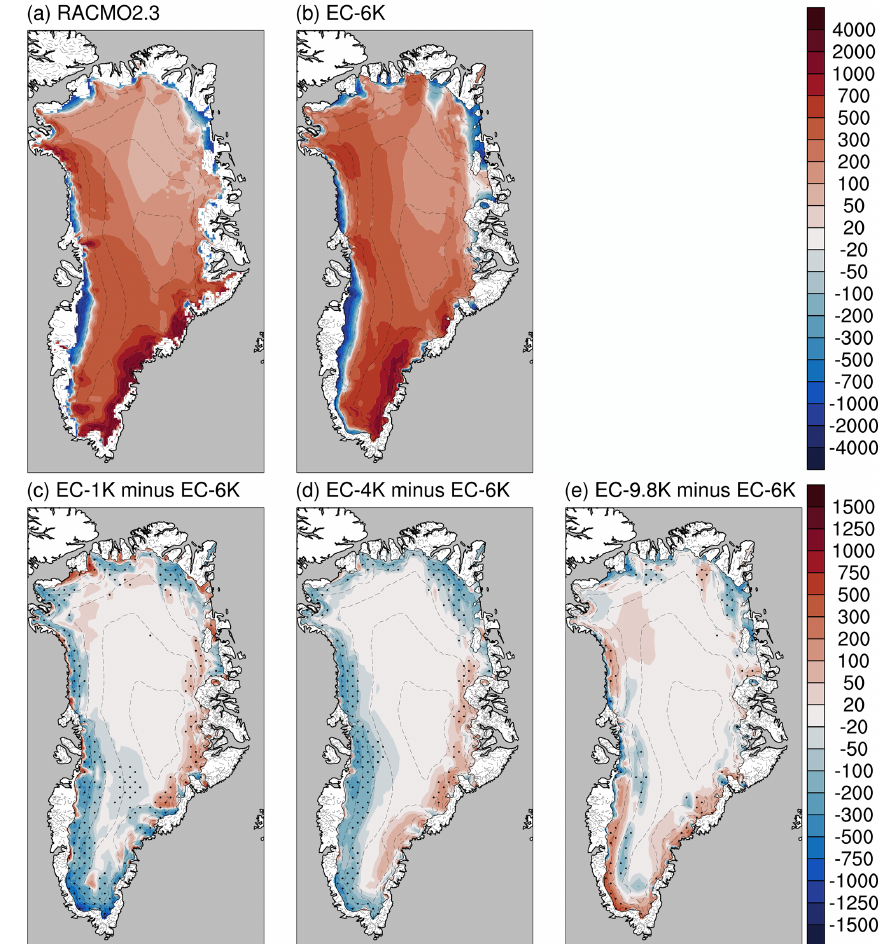
Figure 4. Climatological (1965–2005) SMB for RACMO2.3 (a) , CESM1.0 downscaled to 5km (b) , and SMB anomalies (c, d, e) (mmyr − 1 ) using lapse rates (c) 1Kkm − 1 , (d) 4Kkm − 1 , and (e) 9.8Kkm − 1 . Anomalies are with respect to the default lapse rate of 6Kkm − 1 . Solid black contour shows the ice sheet margin. Elevation contours (dashed) are plotted every 500m. The black line shows the ice sheet margin. Black dots show where differences are significant at the 95% level according to a Student t